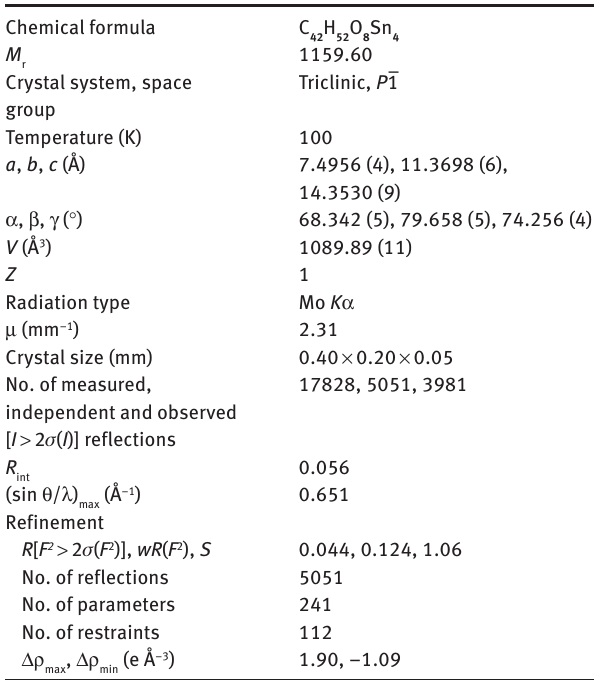
Table 1: Crystal data and refinement details for tin(IV) complex.